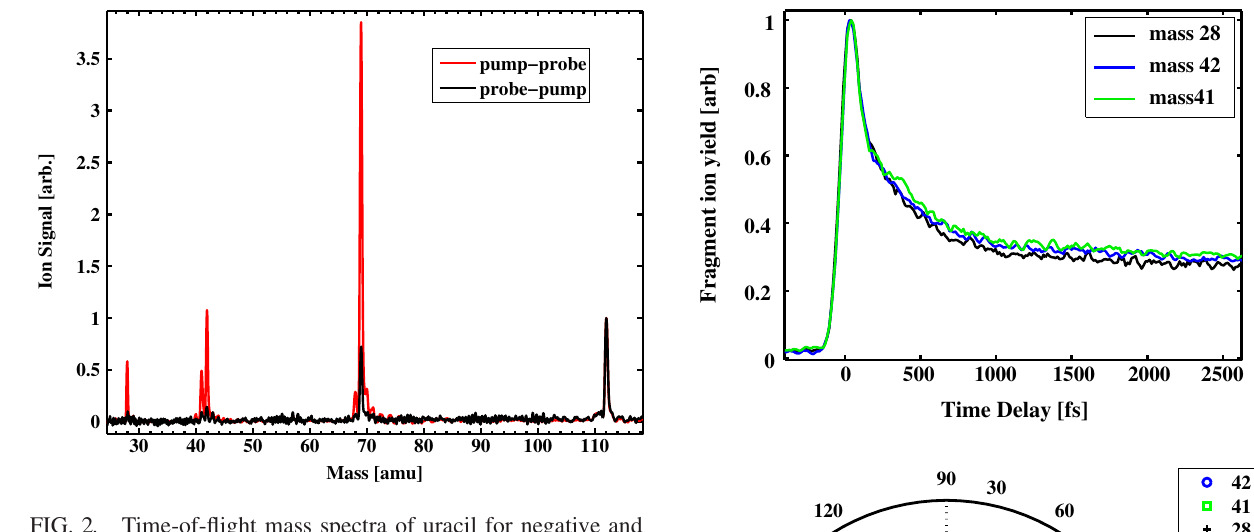
FIG. 2. Time-of-flight mass spectra of uracil for negative and positive time delays ( þ = (cid:2) 200 fs ). Both spectra are normalized to the parent-ion yield.